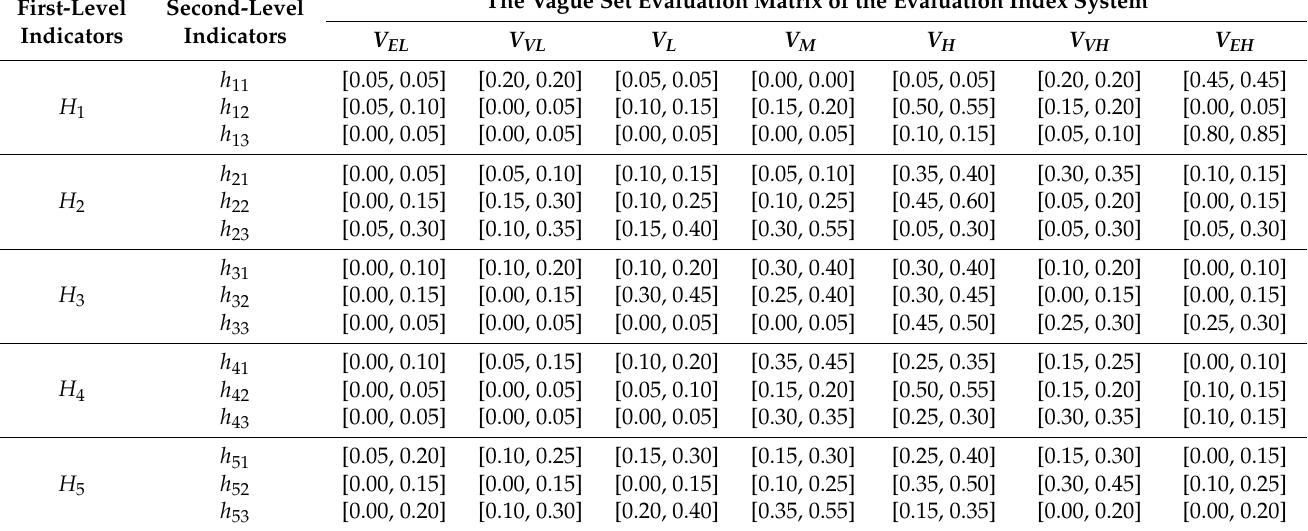
Table 4. Expert reviews on Vague value of indicators.